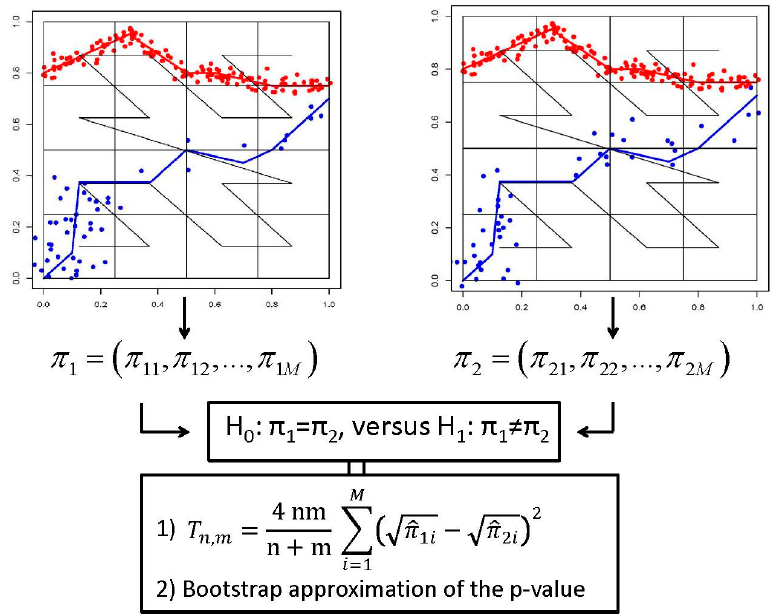
Figure 3. Graphical idea of the proposal.